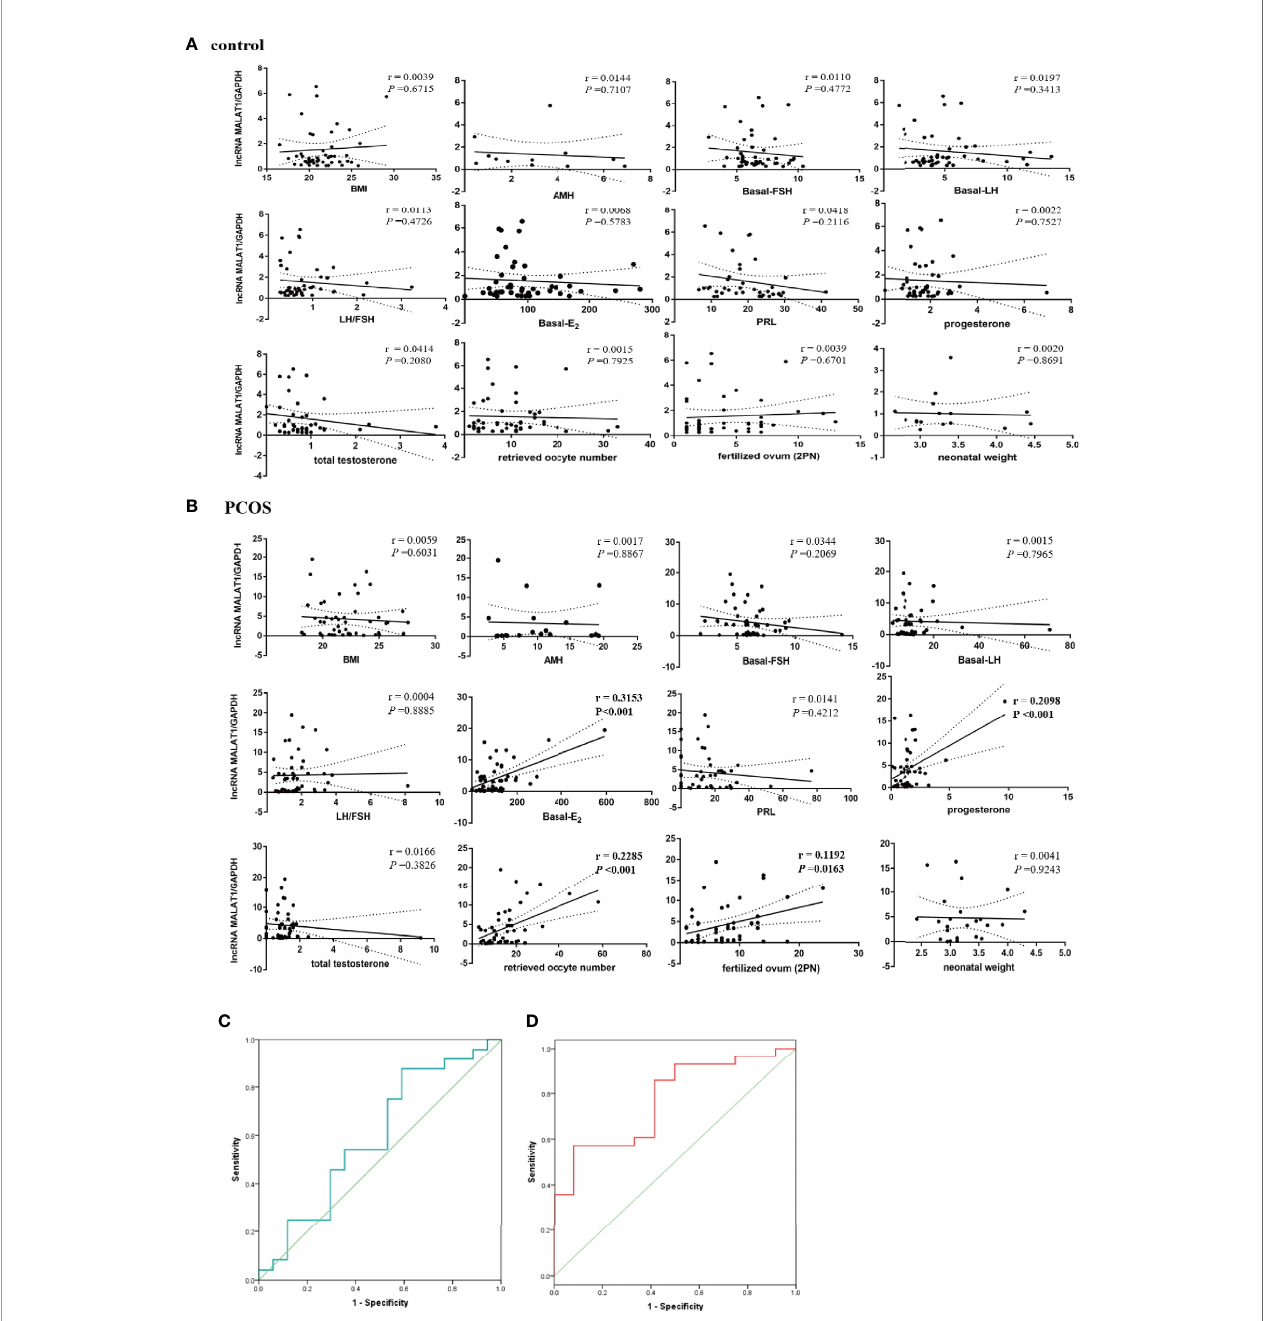
FIGURE 4 | Correlations between MALAT1 expression and clinical parameters. (A) Graph showing correlation between the relative expression of MALAT1 in GCs of control patients and clinical parameters. (B) Graph showing correlation between the relative expression of MALAT1 in GCs of OCOS patients and clinical parameters. (C) ROC curve showing diagnosis value of MALAT in GCs for the positive clinical pregnancy in women without PCOS. (D) ROC curve showing diagnosis value of MALAT in GCs for the positive clinical pregnancy in women with